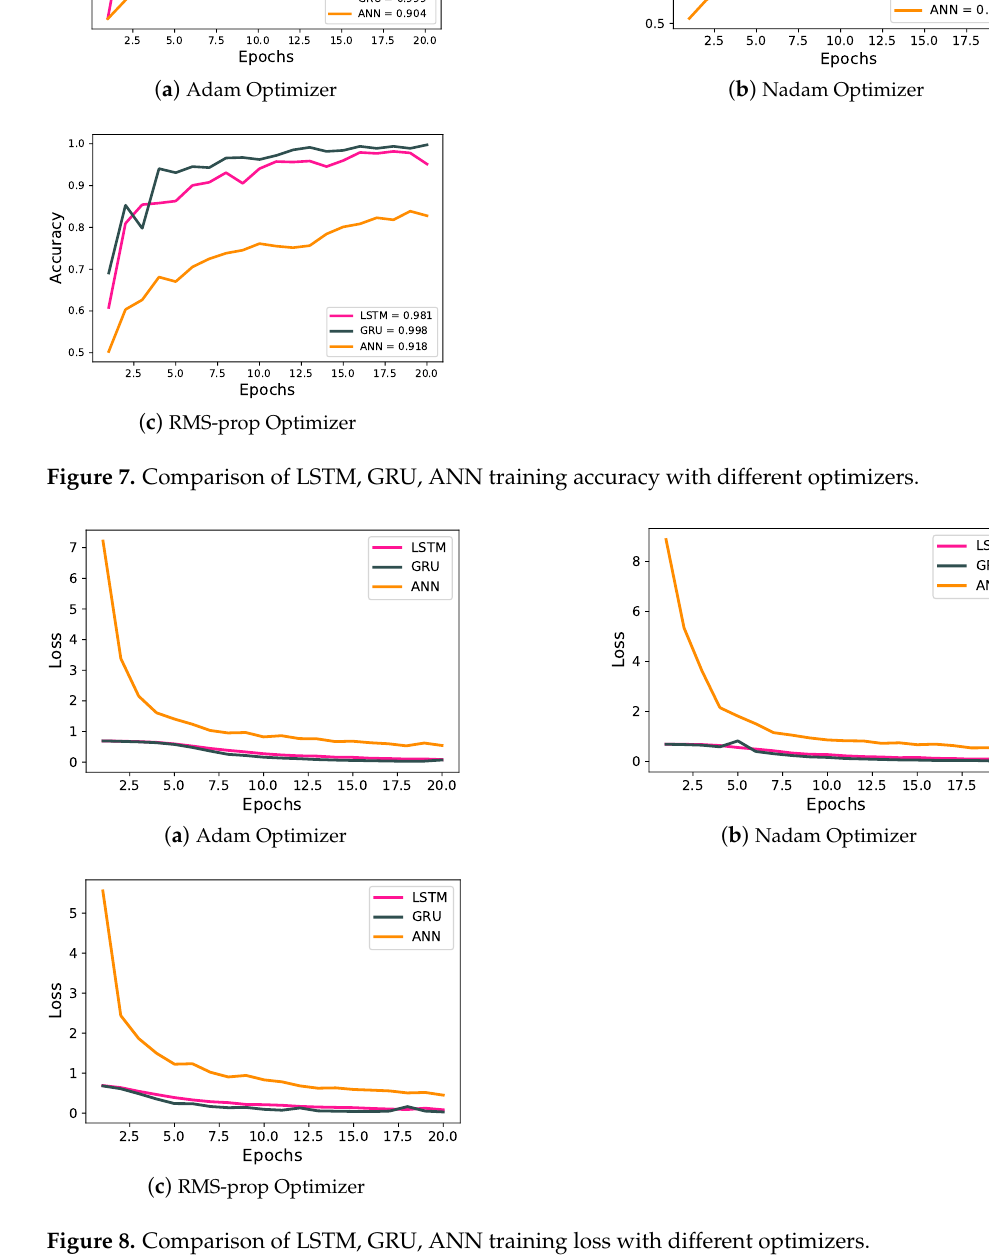
Figure 8. Comparison of LSTM, GRU, ANN training loss with different